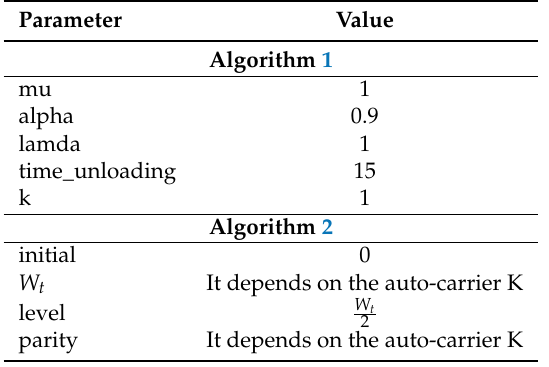
Table 4. Parameters of the proposed heuristic algorithm.